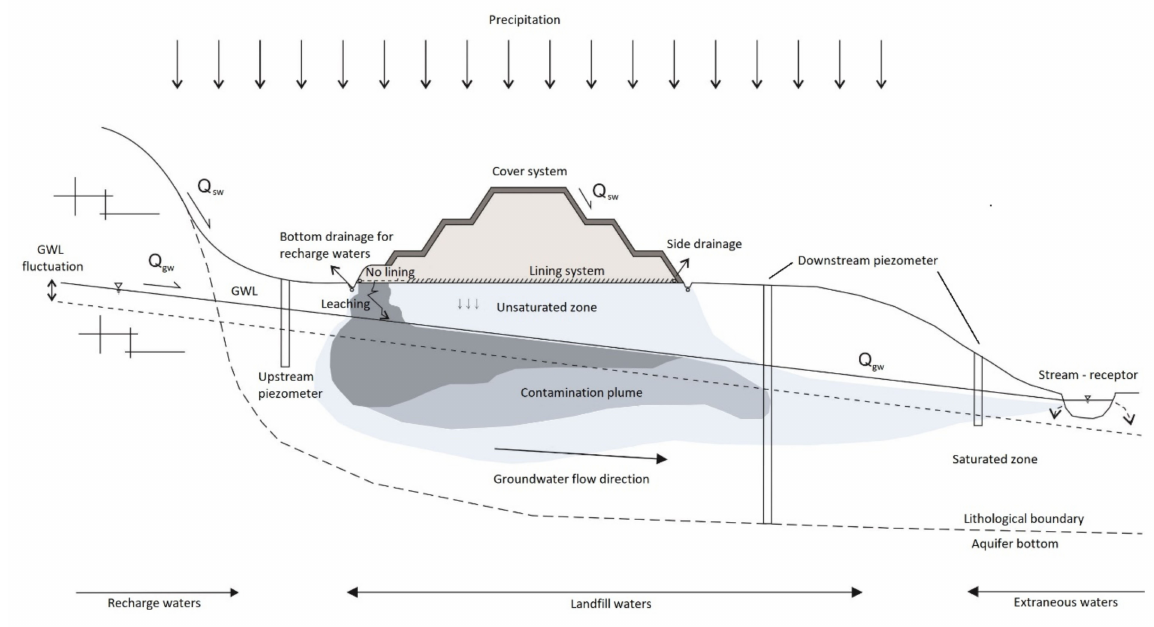
Figure 3. Conceptual model of the